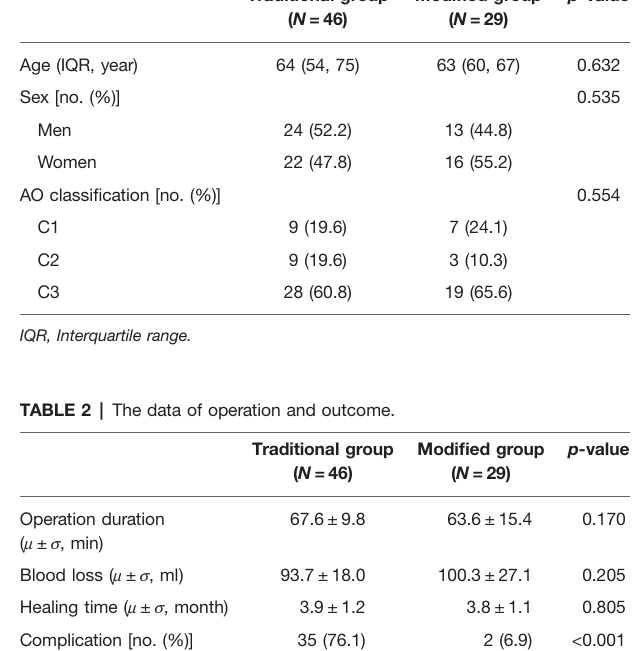
KSS, knee society score; IQR, Interquartile range.